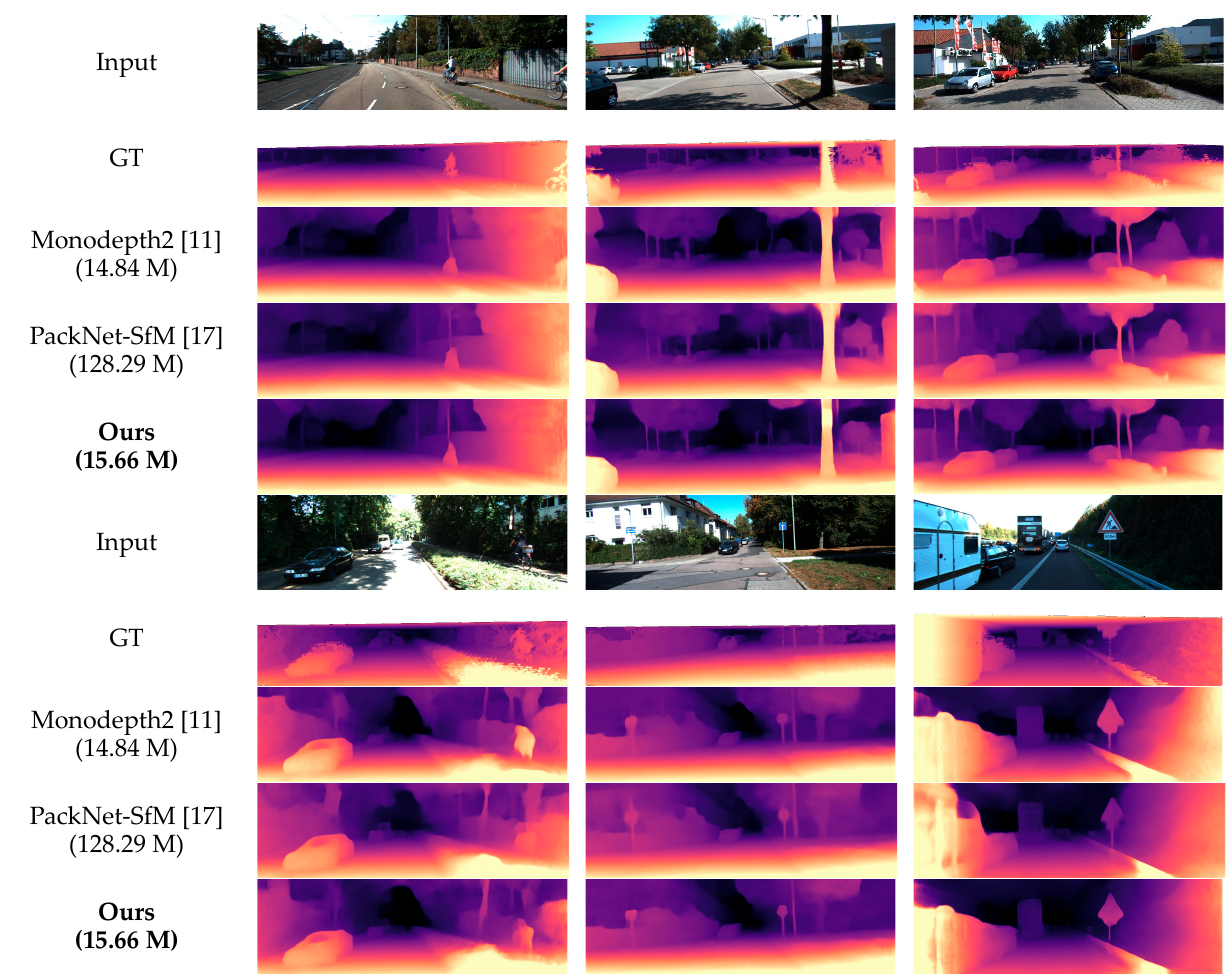
Figure 6. Qualitative results on the KITTI Eigen test split [44]. Ground truth depth maps (row 2 and row 7) are interpolated from sparse point clouds for visualization purposes. Here we use ResNet-18 as the backbone of our SHdepth